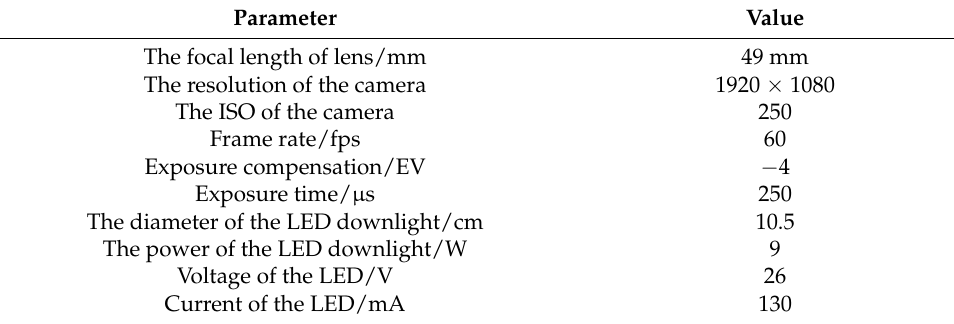
Table 1. Hardware parameters of the